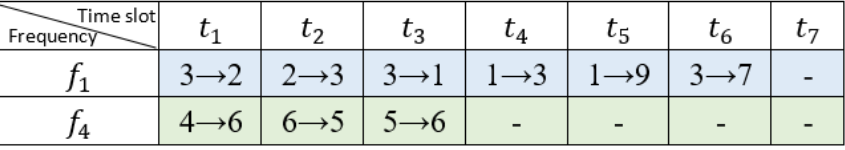
Figure 15. Time slot and frequency distribution of sub-net’s